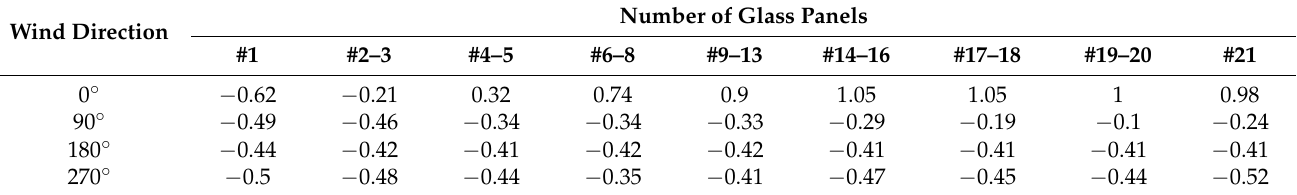
Figure 5. Pressure measurements of the LGCW.  of the LGCW. sl